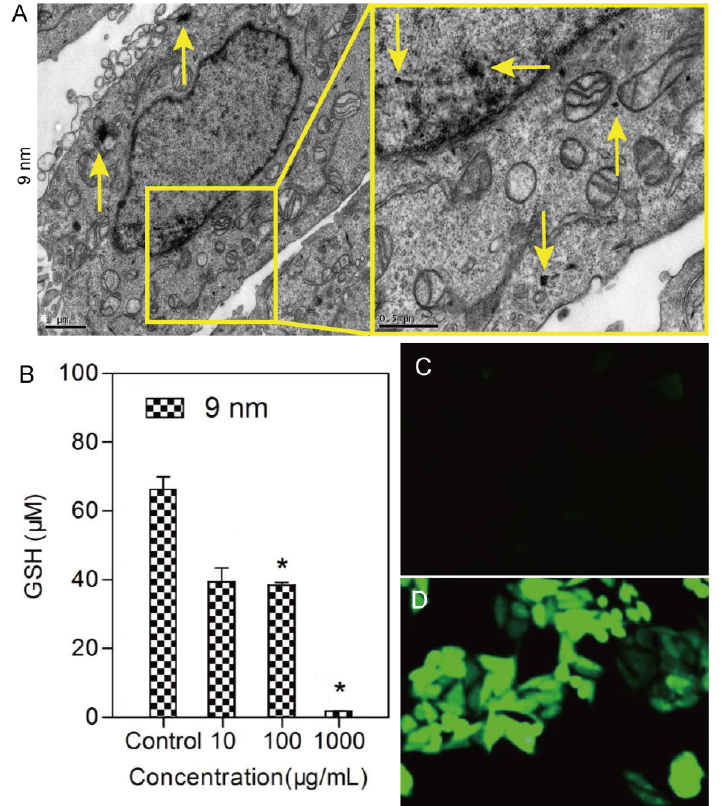
Figure 5: The production of GSH and ROS induced by nanoparticles: (A) Intracellular distribution image of Fe 3 O 4 NPs in cells exposed to Fe 3 O 4 NPs (600 µ g/mL) for 3 h. The corresponding image (right) is the magnified image of regional image in A figure. (B) GSH level of cells treated with Fe 3 O 4 NPs for 48h. The ROS images of cells treated separately with control (C) and 9 nm Fe 3 O 4 NPs (D) for 48h. Data are presented as mean ± S.D.